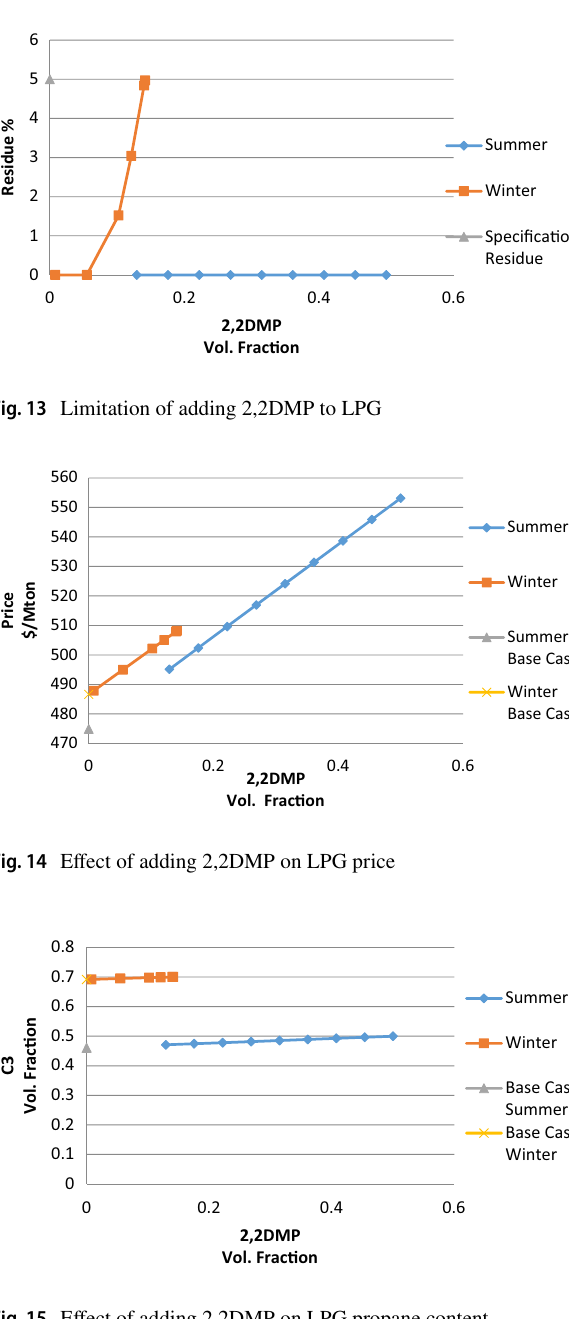
Fig. 15 Effect of adding 2,2DMP on LPG propane